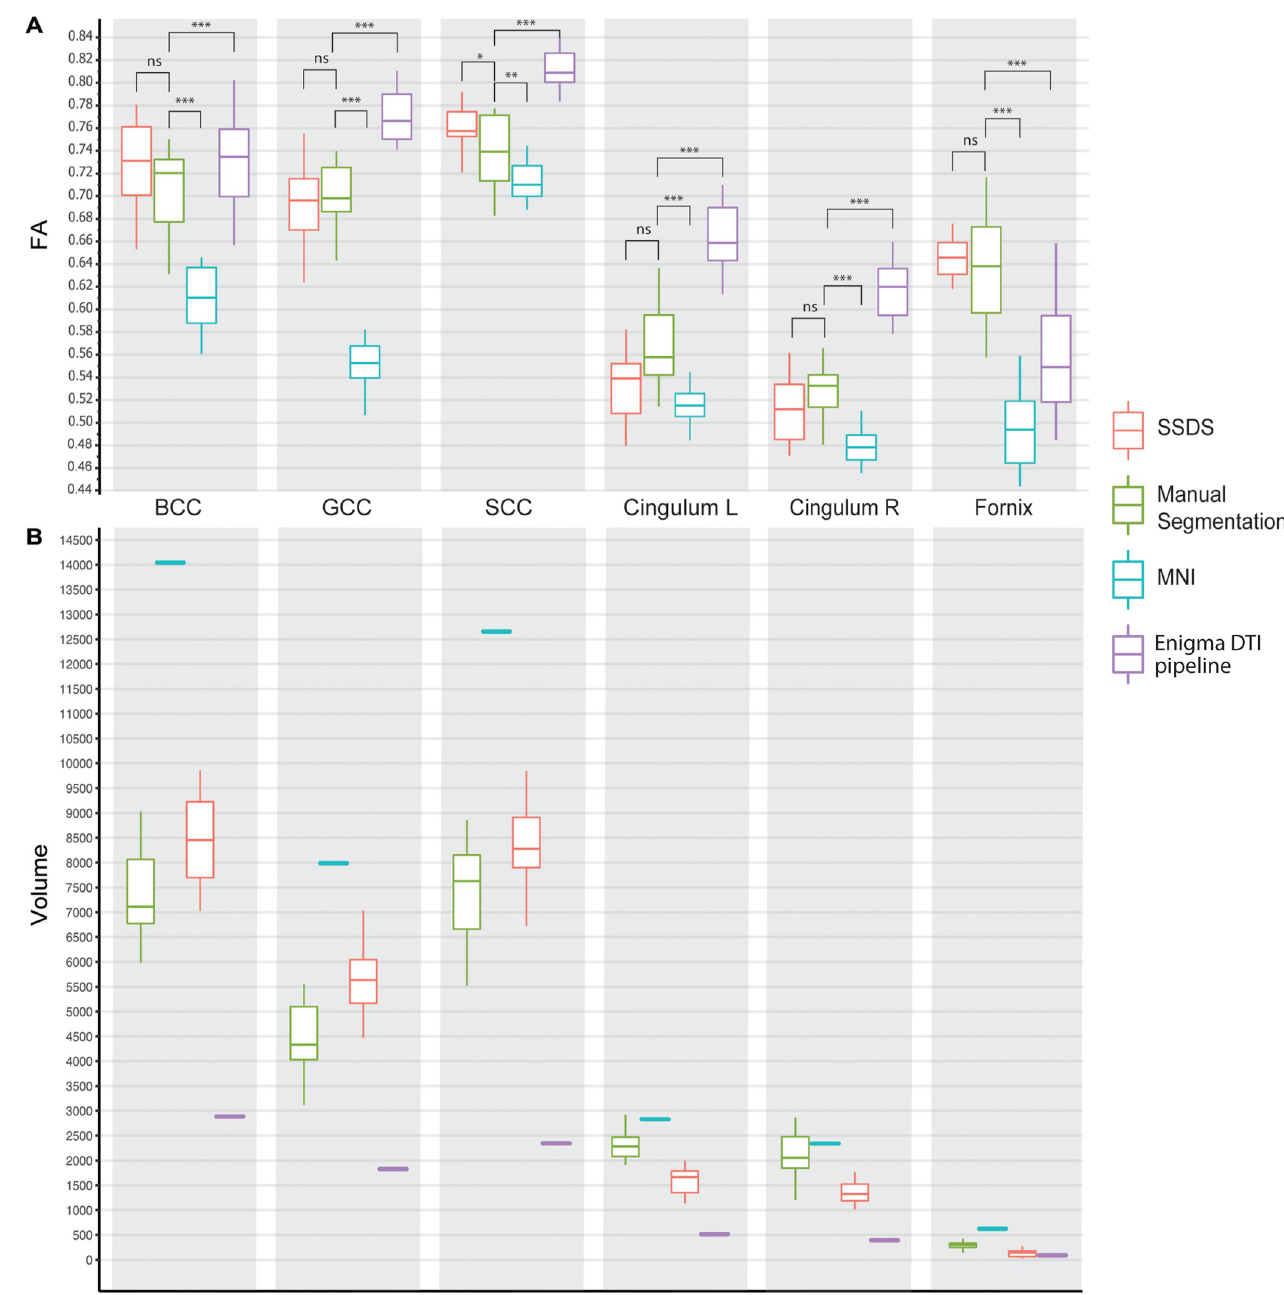
Fig 8. Boxplots of mean FA and volumes of ROIs. Boxplot comparing mean FA values (A) and volume in mm 3 (B) in n = 15 healthy controls for 4 segmentation methods of the body, genu and splenium of the corpus callosum (BCC, GCC, SCC respectively), fornix and cingulum bilaterally. The four segmentation methods include SSDS, a manual segmentation on the parametric map, crossing ROI with normalized FA in MNI152 template space, and extracting the mean skeletonised FA value of each ROI mask. Although the fornix was omitted from analysis (because of a poor test -retest reliability), we included segmentation of the fornix to illustrate comparisons of the methods on a small tract. Ns = not significant, � p < 0.05, �� p < 0.01, ��� p <